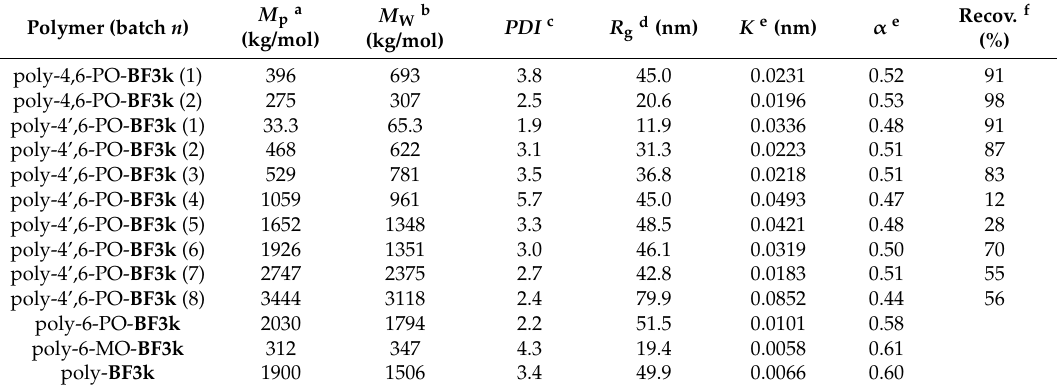
Table 1. Macromolecular features of the newly-synthesized poly-4,6-PO- BF3k and poly-4’,6-PO- BF3k compared with those shown by previously reported poly-6-PO- BF3k , poly-6-MO- BF3k , and poly- BF3k . Polymer (batch n